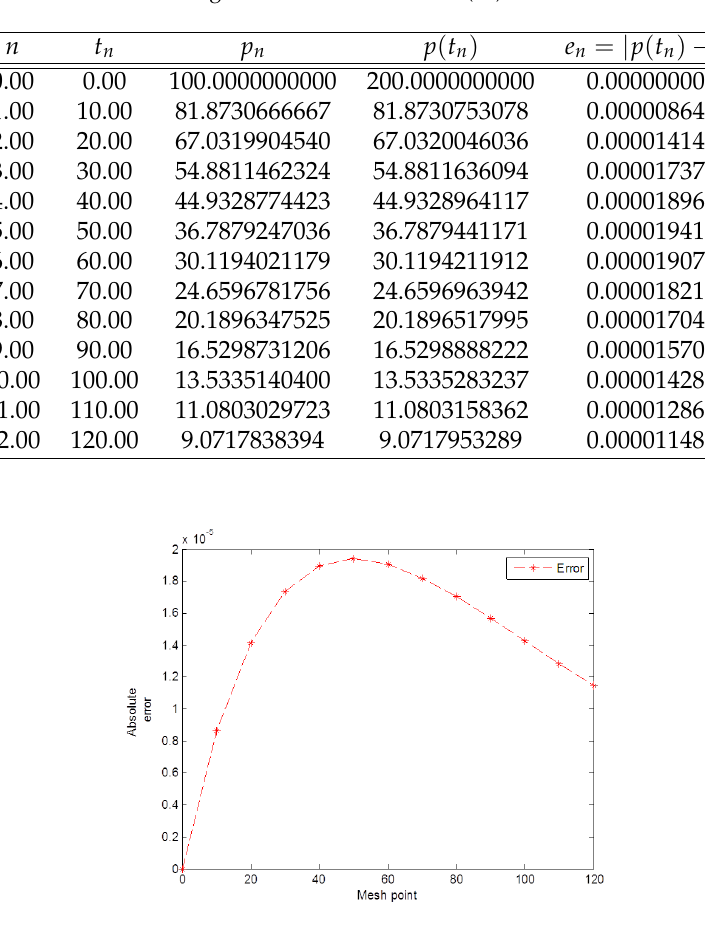
Table 2. The results generated via the scheme (40) and the exact solution